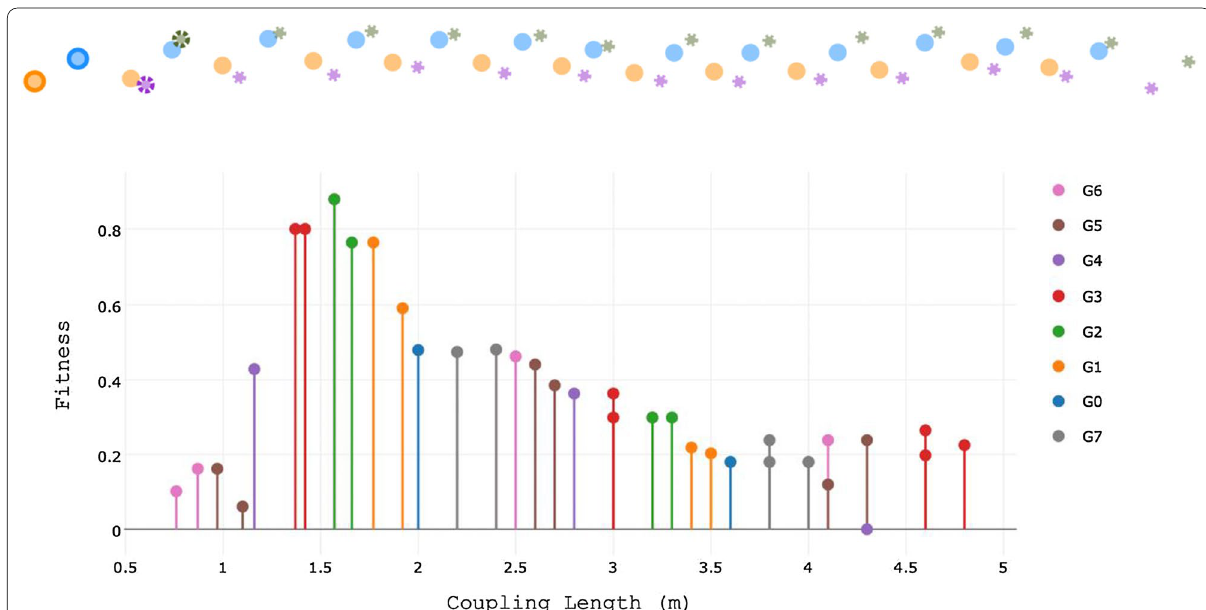
Fig. 11 The S3 sauropod trackway, a contiguous segment of BEB-500-S3 of the Courtedoux-Béchat Bovais tracksite (Marty et al., 2007). The results of the best-fit solutions are statistically indistinguishable from those of the S1 trackway (Fig. 8), suggesting the two trackmakers had very similar size and gait